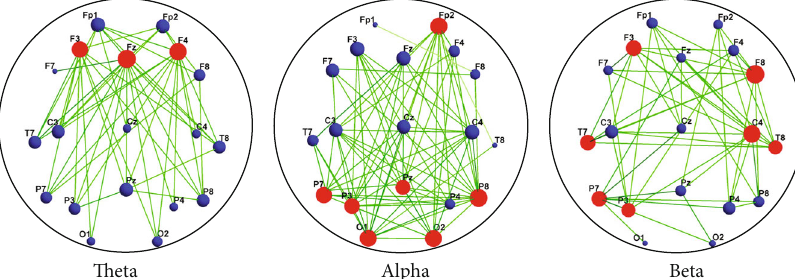
Figure 5: Di ff erence statistical networks. Red nodes represent the hub nodes. Blue nodes represent the nonhub nodes. Node size re fl ects the degree. Table 2: Node degrees of the di ff erential networks. Node